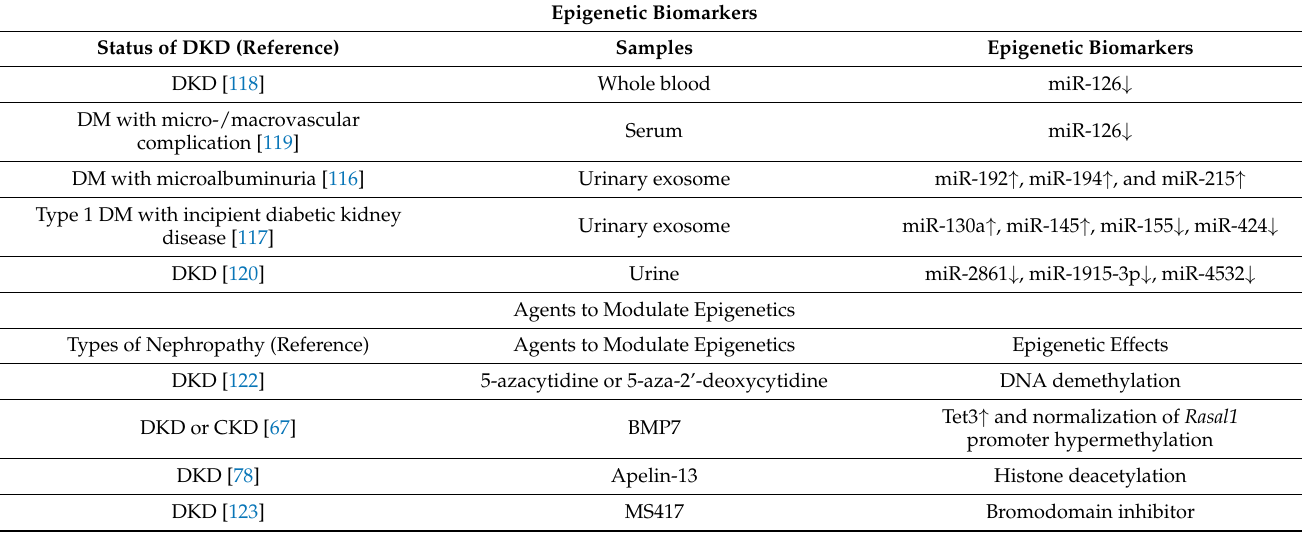
Table 4. Epigenetic biomarkers and agents to modulate epigenetics in diabetic kidney disease. Epigenetic